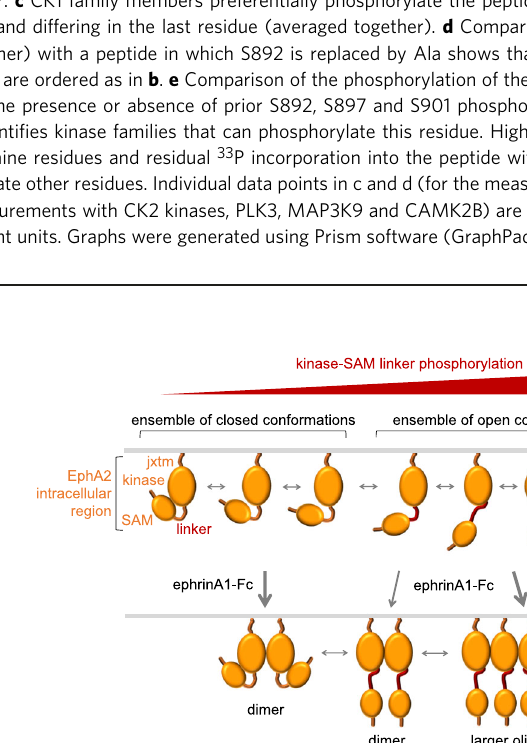
Fig. 8 Hypothetical model illustrating the proposed effects of phosphorylation on the conformation of the EphA2 intracellular region. In the unphosphorylated, inactive EphA2 intracellular region, the kinase domain interacts with the SAM domain (SAM). Phosphorylation of serine/ threonine residues in the kinase-SAM linker promotes transition to more open conformations. The ephrinA1-Fc ligand induces EphA2 dimerization when phosphorylation of the kinase-SAM linker is low and EphA2 clustering into larger oligomers when linker phosphorylation is